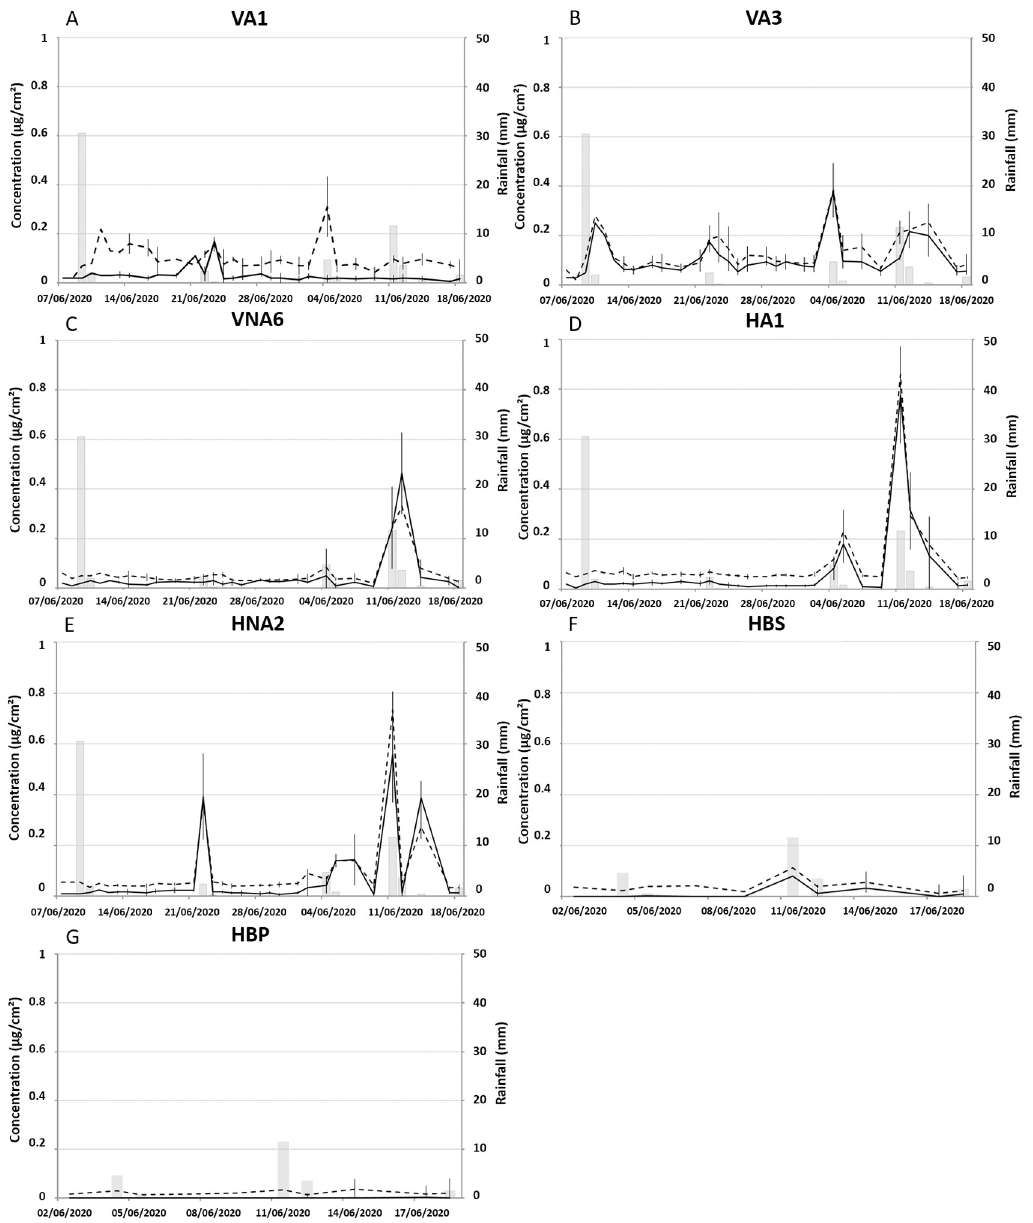
Fig 3. Evolution of microbial concentration (cyanobacteria and green algae) associated with rainfall event for the spring season campaign: For vertical (VA1 (A), VA3 (B), VNA6 (C)), horizontal positions (HA1 (D) and HNA2 (E)) and bleach washed tiles (HBS (F) and HBP (G)). Each point and bar represent the mean and standard deviation based on three replicates.